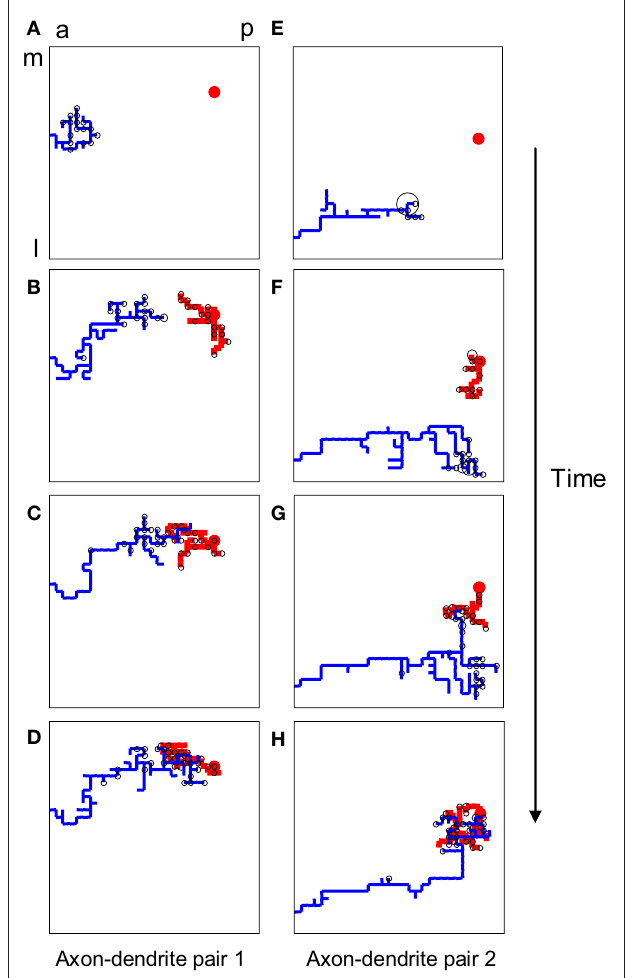
FIGURE 1 | The structure of developing axons and dendrites in silico as a function of time. (A–D) The evolution of the axonal (blue) and dendritic (red) arbor in the model is achieved by creating and eliminating new branches and retracting and elongating existing ones. A particular pair of axons and dendrites is shown out of 900 simultaneously evolving axonal and dendritic arbors. The shown dendrite is the main recipient of the synaptic connections (black circles) for the shown axon, once topography is established. (E–H) The evolution of another pair of axon and dendrite is shown for the same simulation.